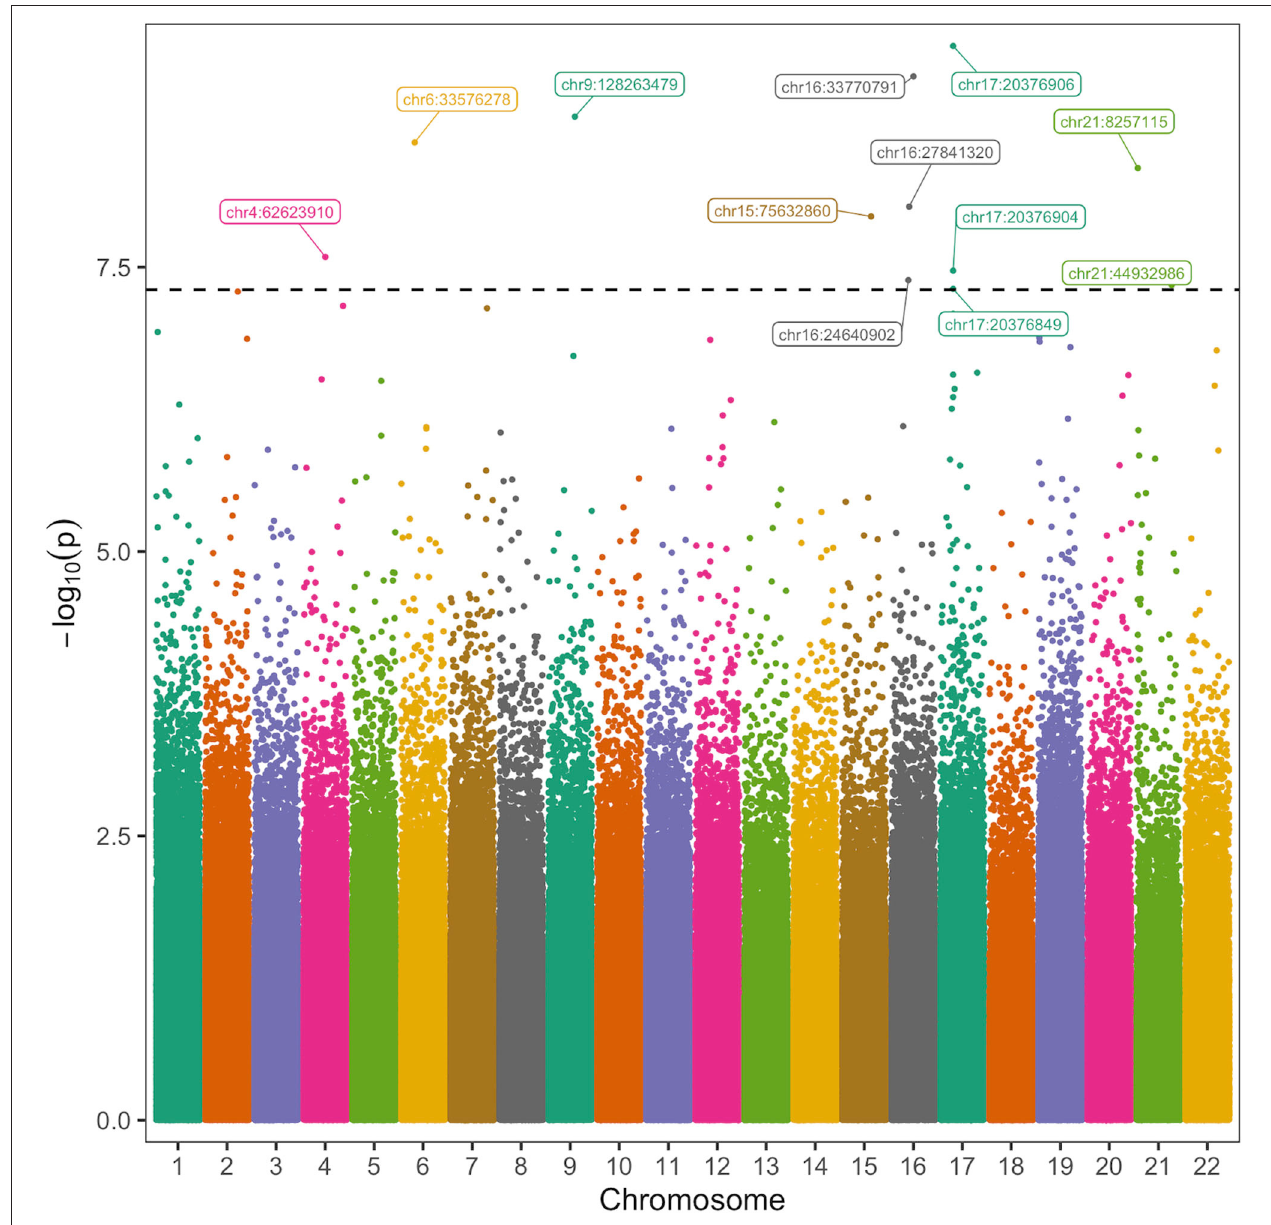
FIGURE 2 | Manhattan Plot of CpGs Associated with Post-operative Atrial Fibrillation. The vertical axis represents the negative log 10 of the p -value of each CpG’s association with POAF. The horizontal axis represents the chromosome and position of each CpG. Twelve CpGs had significant association with POAF after controlling for known clinical and methylation covariates. The black horizontal dashed line corresponds to a p -value of 5 × 10 − 8 .